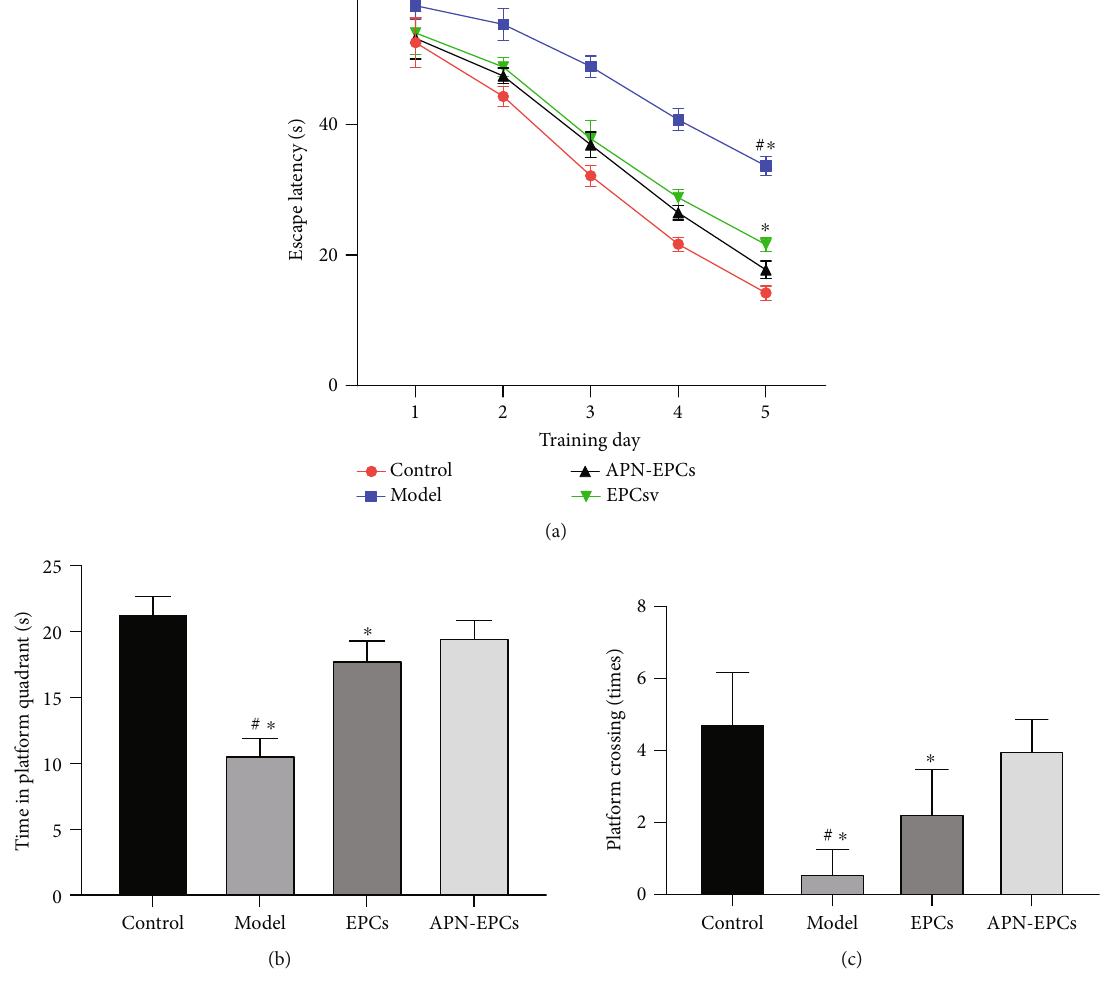
Figure 3: In fl uence of APN-EPC treatment on MWM test of aging rats. (a) The place navigation test. (b) The probe trial. (c) Crossing times. ∗ p < 0 : 05 the model group or the EPC group compared with the APN-EPC group, # p < 0 : 05 the model group compare with the control